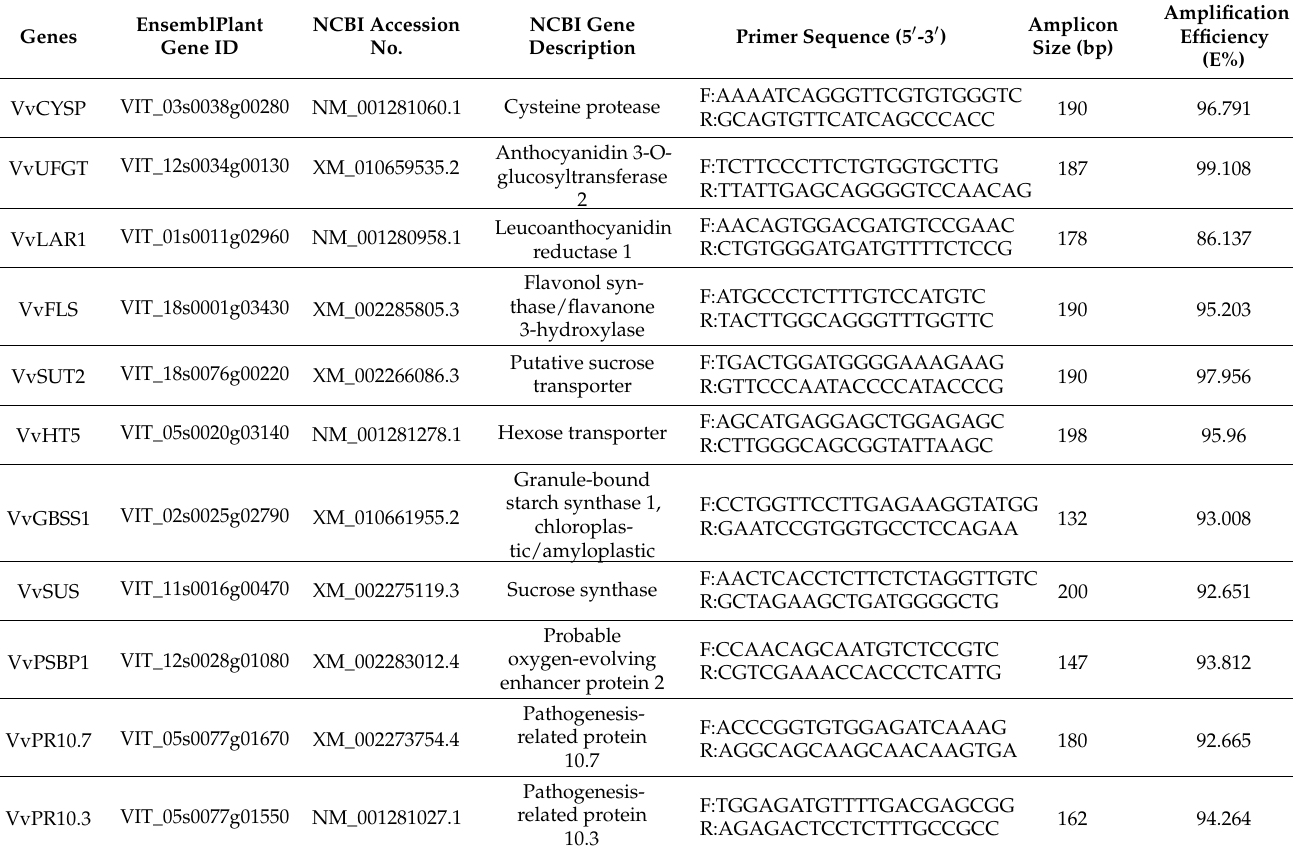
Table 1. Primer design